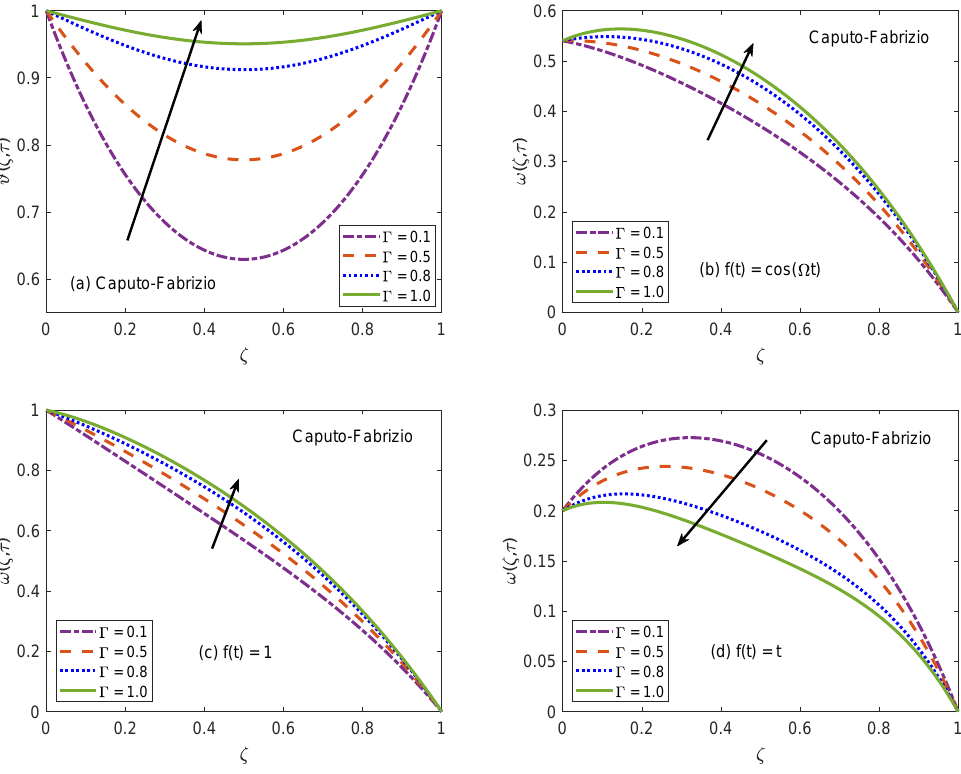
Figure 7. Temperature and velocity patterns of CF model for variation of Γ